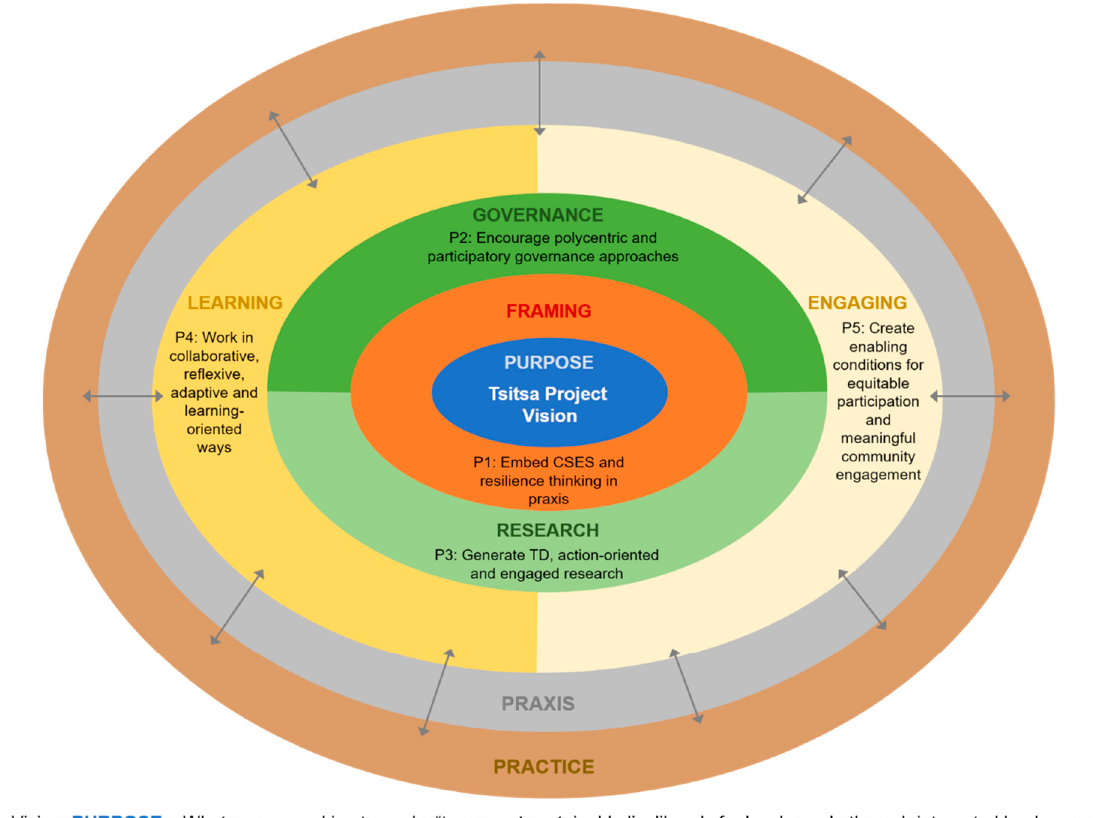
Figure 4. Conceptual presentation of five layered principles (P1–P5) that guide the Tsitsa Project. The principles inform two-way praxis, at the interface of theory and practice. (CSES—complex social ecological system;